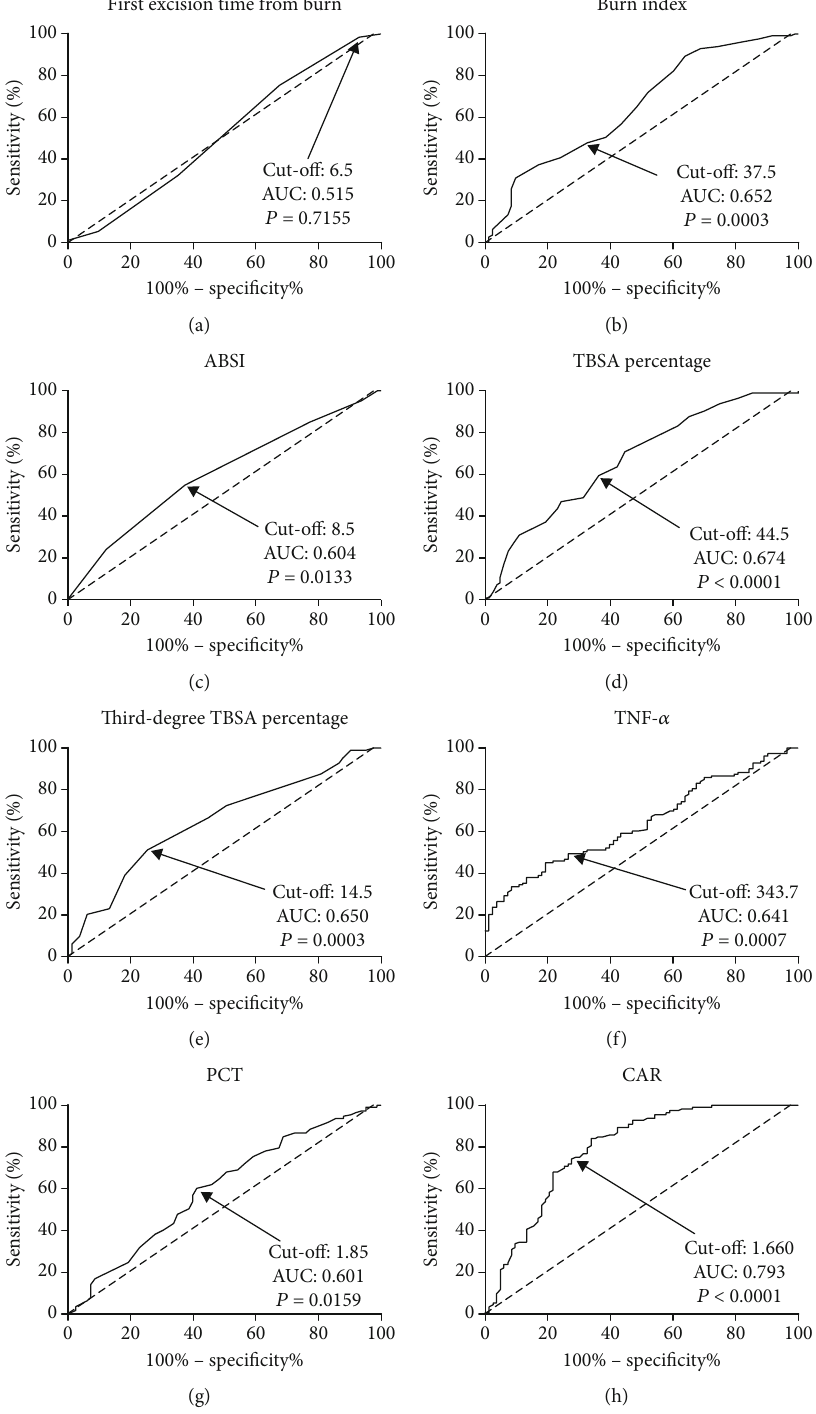
Figure 2: Predictive values of variables for sepsis in severe burns by ROC curve analysis. (a) First excision time from burn; (b) burn index; (c) ABSI; (d) TBSA percentage; (e) third-degree TBSA percentage; (f) TNF- α ; (g) PCT; (h) CAR. CAR at admission was the most signi fi cant predictor with a cut-o ff value of 1.66, an AUC of 0.793, a sensitivity of 74.34%, and a speci fi city of 72.29% ( P < 0 : 0001 ). CAR: C-reactive protein-to-albumin ratio; ABSI: abbreviated burn severity index; TBSA: total burn surface area; PCT: procalcitonin; TNF- α : tumor necrosis factor- α ; ROC: receiver operating characteristic; AUC: area under the